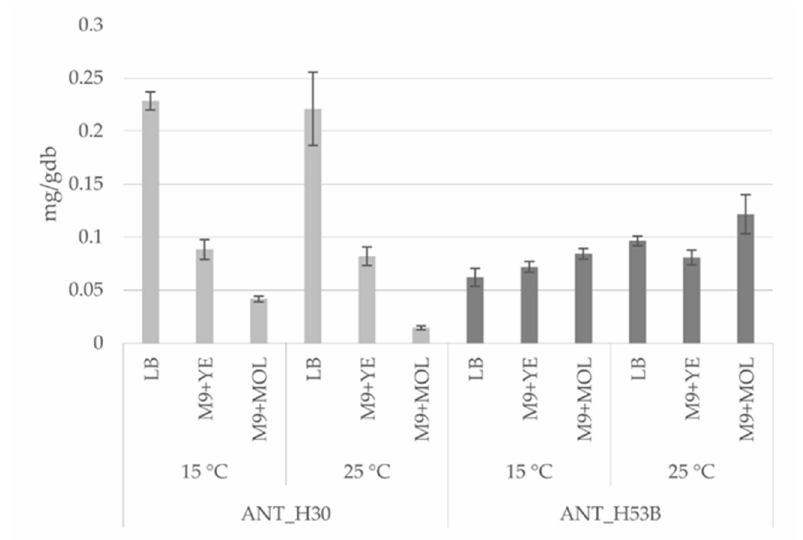
Figure 4. The quantity of extracted crude carotenoids from Planococcus sp. ANT_H30 and Rhodococcus sp. ANT_H53B cultivated in various media and at various temperatures.